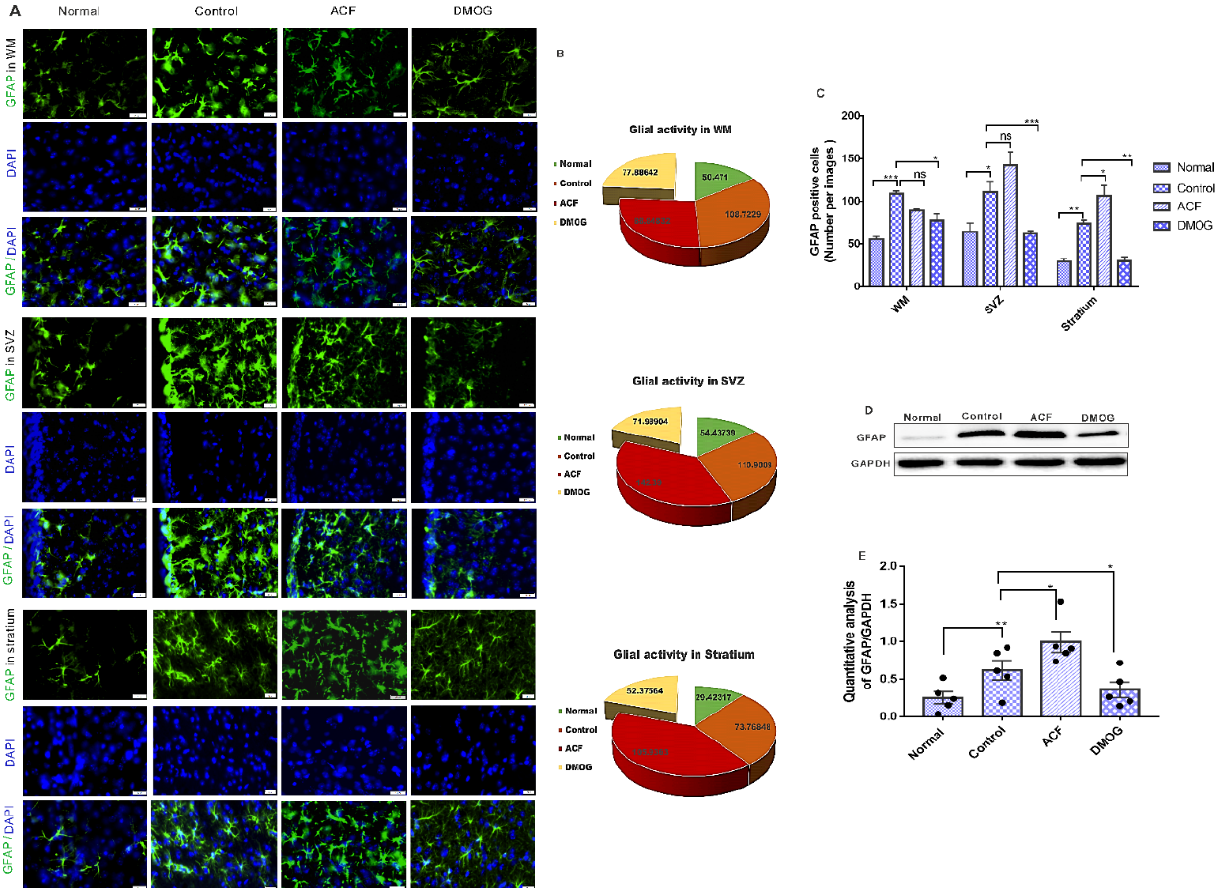
Figure 7. HIF-1 α reduces the glial activation after ET-1 injection in WM, SVZ and striatum. ( A ) Immunofluorescence staining of GFAP positive cell in WM, SVZ and Striatum, Scale bar 20 µ m, ( B ) 3D-Pie diagram show the proportion of whole GFAP positive cells within each area ( C ) Number of GFAP positive cells; Control Vs. Normal WM *** p < 0.001; SVZ * p < 0.05; Striatum * p < 0.01, DMOG Vs. Control WM * p < 0.05; SVZ *** p < 0.001; Striatum ** p < 0.01, ACF Vs. Control WM p = ns; SVZ p = ns; Striatum * p < 0.05, all values are expressed as mean ± SEM, one- way ANOVA, followed by post hoc Tukey test, n = 5. ( D ) Western blot, ( E ) Quantitative analysis of GFAP, Control vs. Normal ** p < 0.01, DMOG vs. Control * p < 0.05, ACF vs. Control * p < 0.05. all values are expressed as mean ± SEM, one- way ANOVA, followed by post hoc Tukey test, n =